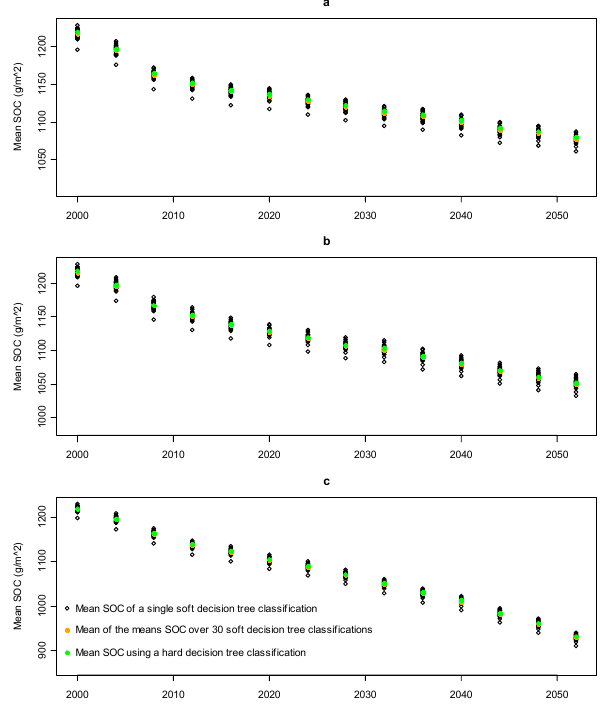
Fig. 8. Mean GEMS modeled soil organic carbon (SOC) computed for all the study area for the period 2000 to 2052, under the (a) no, (b) low , and (c) high climate change